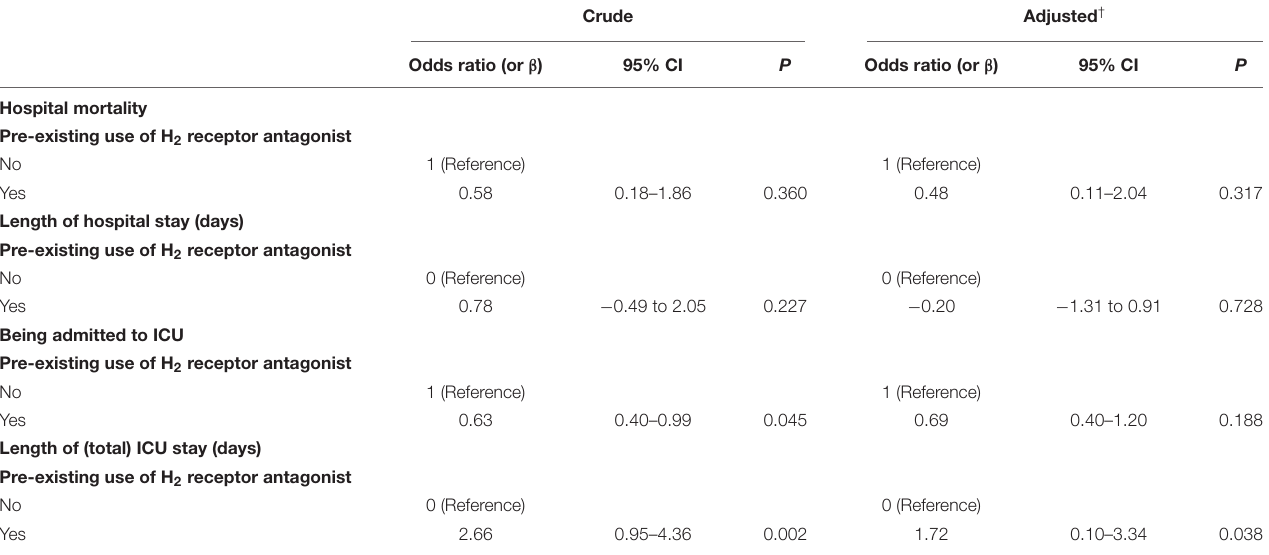
TABLE 4 | Associations of pre-existing use of H2 receptor antagonist and prognosis of the study